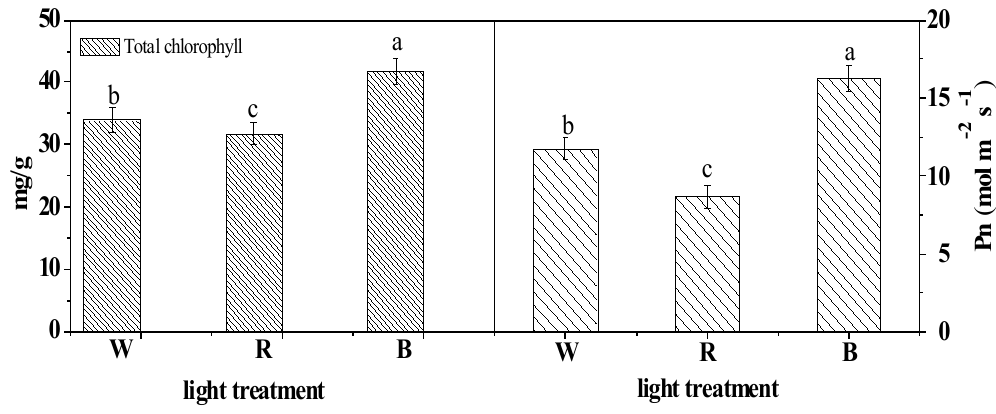
Figure 2: Effects of 24 h continuous light on net photosynthetic rate and chlorophyll content.